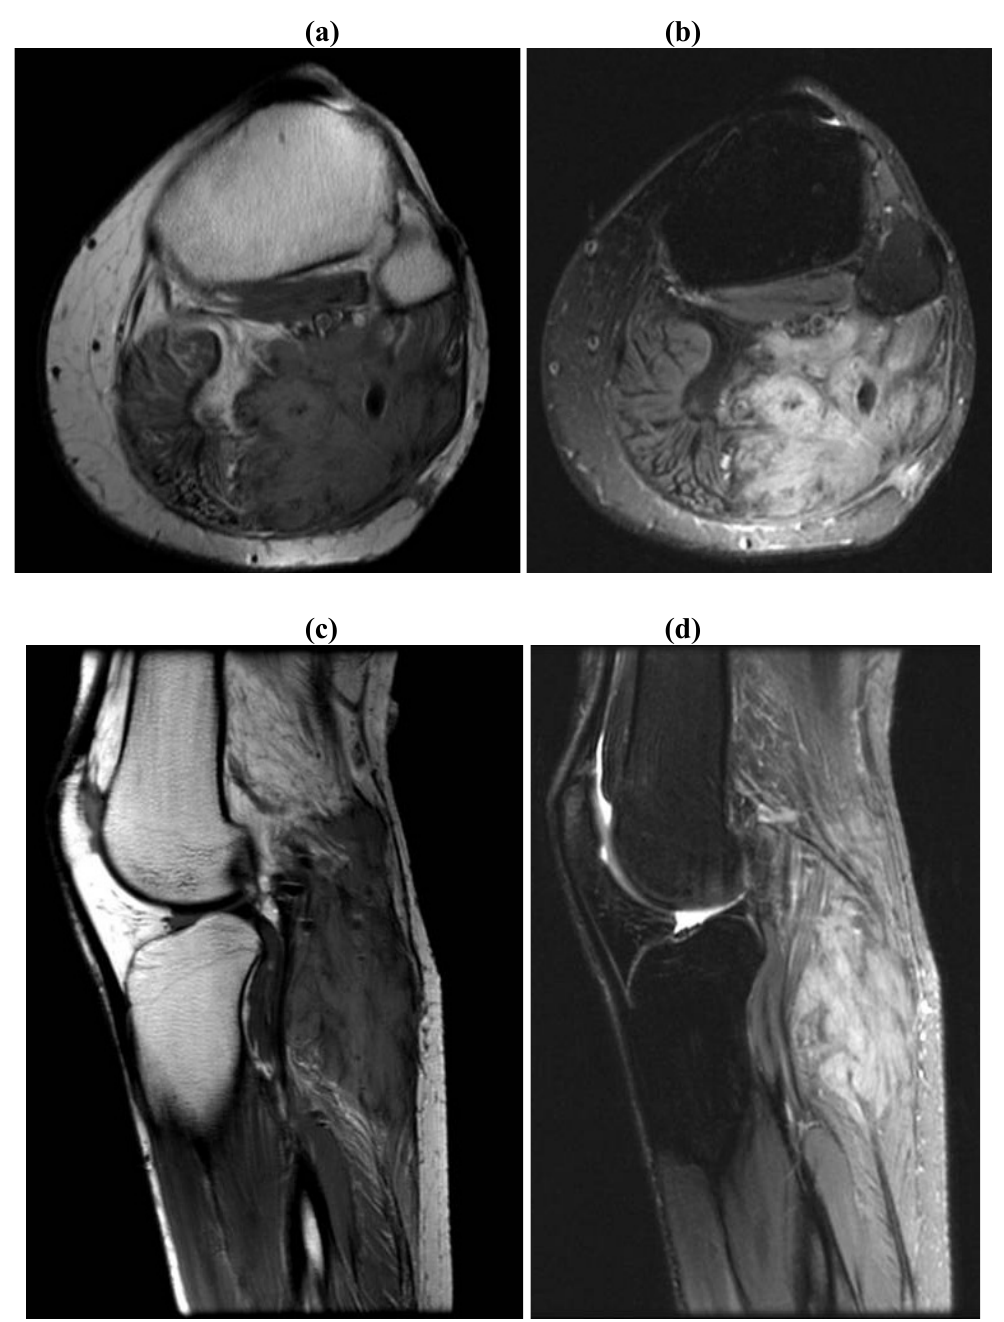
Figure 1. 30/F with unresectable recurrence of desmoid tumor involving the posterior aspect of the left proximal calf. Initial tumor appeared during pregnancy and was resected following delivery. The recurrence was treated with close observation, discontinuation of oral contraceptives and sulindac. MRI findings: A large lobulated infiltrating mass with unusual architecture extending from just above the knee distally into the upper calf. The mass measures approximately 4.4 × 6.5 cm in axial diameters ×13.4 cm craniocaudal dimension. There are areas of relatively low T2 signal and avid gadolinium enhancement within the mass which could be seen with desmoid tumor. (a) Axial T1; (b) Axial